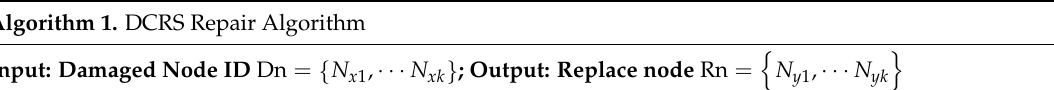
Figure 3. Logical Relationship of Data Partitioning.